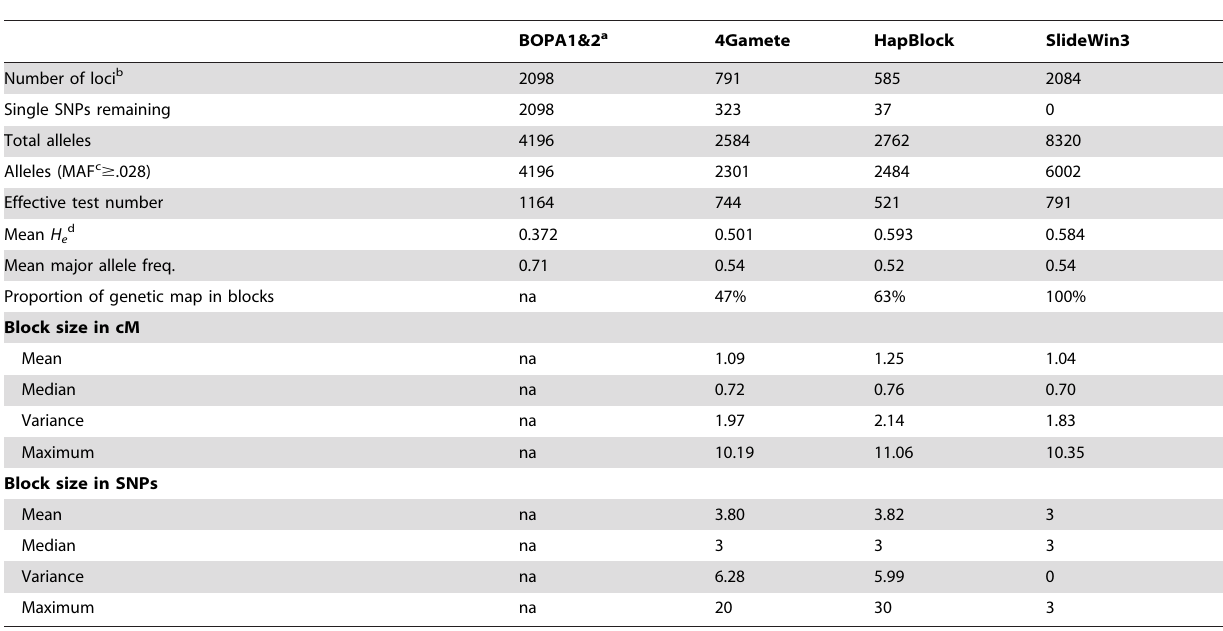
Table 2. Comparison of single SNPs and haplotype blocks inferred by the three blocking methods.